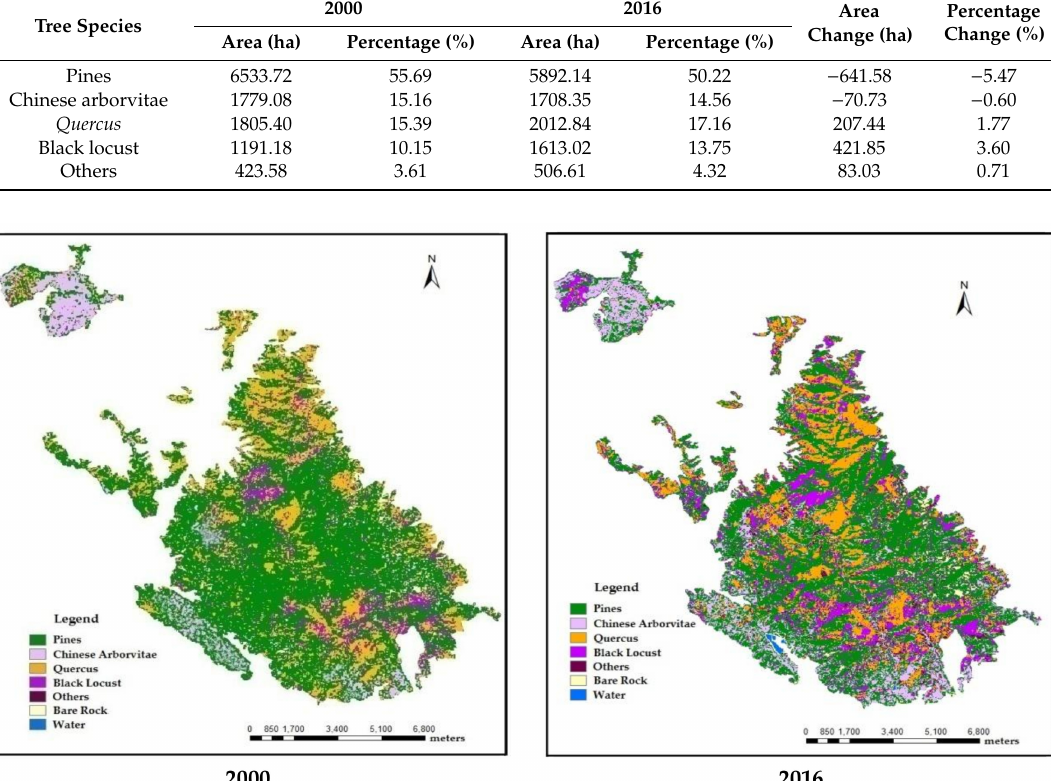
Figure 5. Species distribution